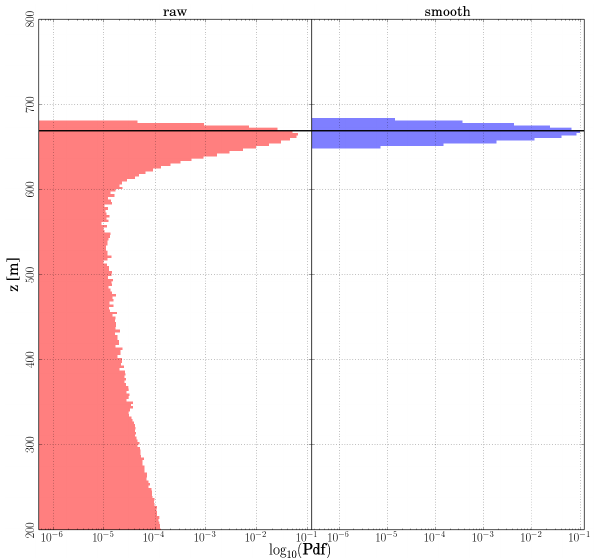
Figure 2. Results of a Monte Carlo for the parcel method as de- tailed in algorithms presented in Sect. 2.1. The first panel presents the probability density function of the Monte Carlo using the data directly. In the second panel the results are for data smoothed with a window of three points instead. The algorithms were applied to the synthetic profile of Fig. 1 after application of random noise. The number of runs performed is 1000000. The probability density is presented on a logarithmic scale to allow the view of results far from the expected MH. The expected MH is presented as a black horizontal